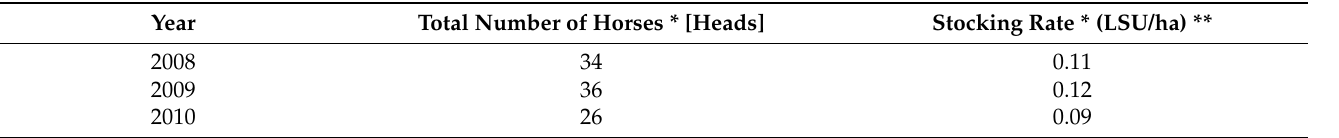
Table 1. Total number of Koniks and stocking rate in the Biebrza National Park